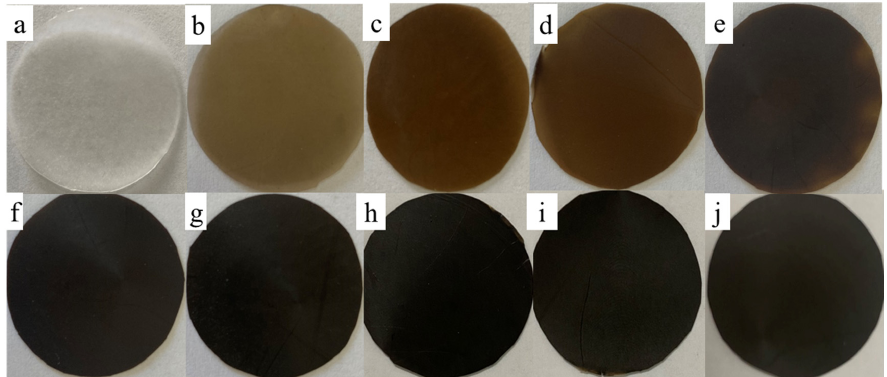
Figure 2. Photographs of the pure TPU film ( a ) and GO-TPU films prepared with the initial concentration of 20 wt % TPU and the loadings of GO of 0.1 wt % ( b ), 0.3 wt % ( c ), 0.6 wt % ( d ), 1 wt % ( e ), 2 wt % ( f ), 3 wt % ( g ), 4 wt % ( h ), 5 wt % ( i ), and 7 wt % ( j ), respectively.